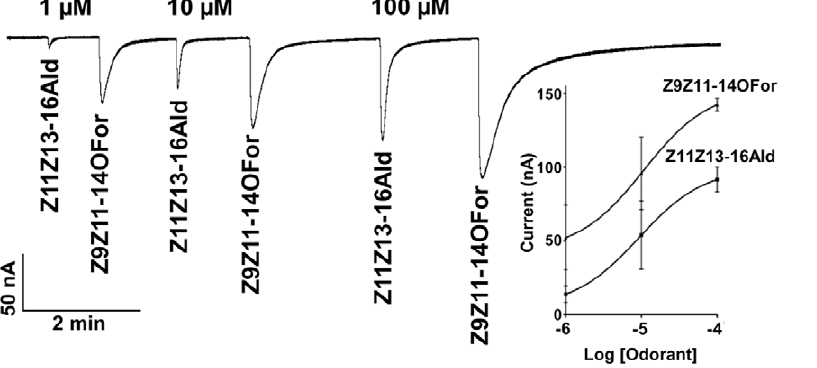
Figure 8. Current responses elicited from AtraOR1 N AtraOrco-expressing oocytes by challenging the same oocytes with the aldehyde pheromone and its parapheromone. To avoid electrophysiological adaptation, dose-dependence relationships were obtained with a narrow range of concentration, n =4.